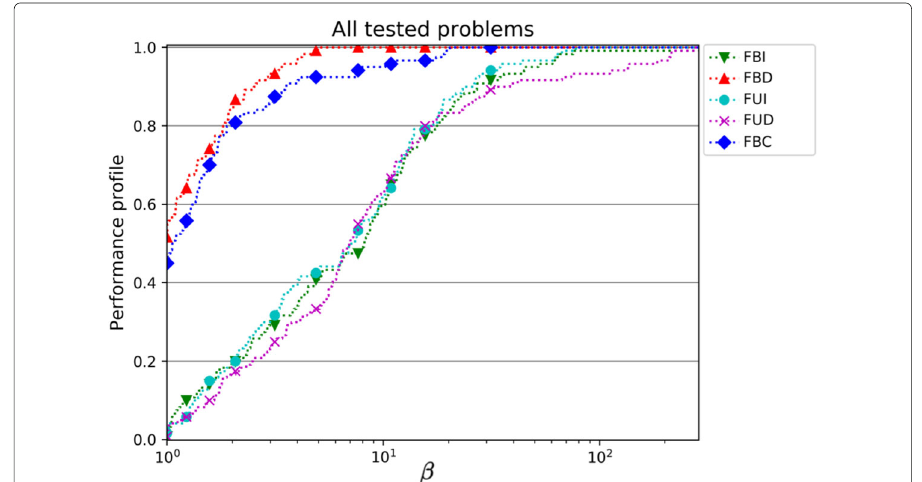
Fig. 10 Performance profile for first order MethodsFBI,FBD,FUI,FUD,FBC , for all performed